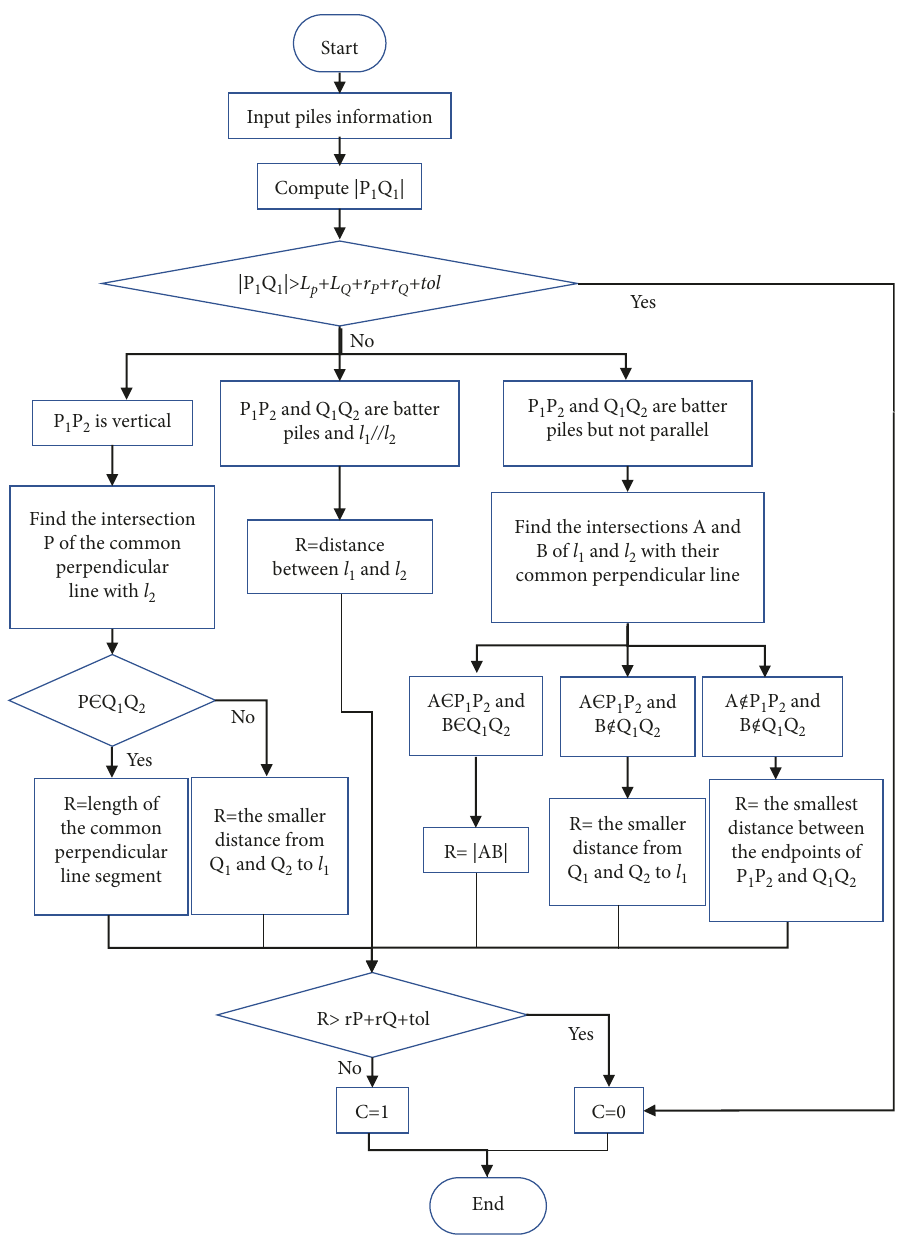
Figure 4: The flowchart of the check function for pile